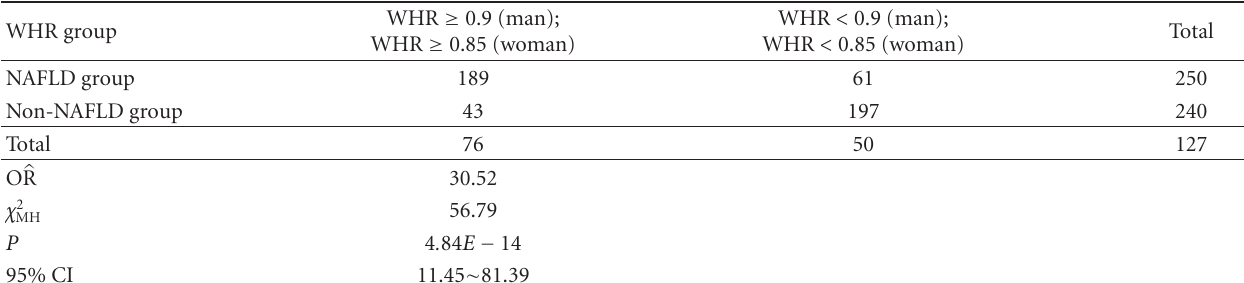
Table 3: Correlation between WHR and NAFLD.